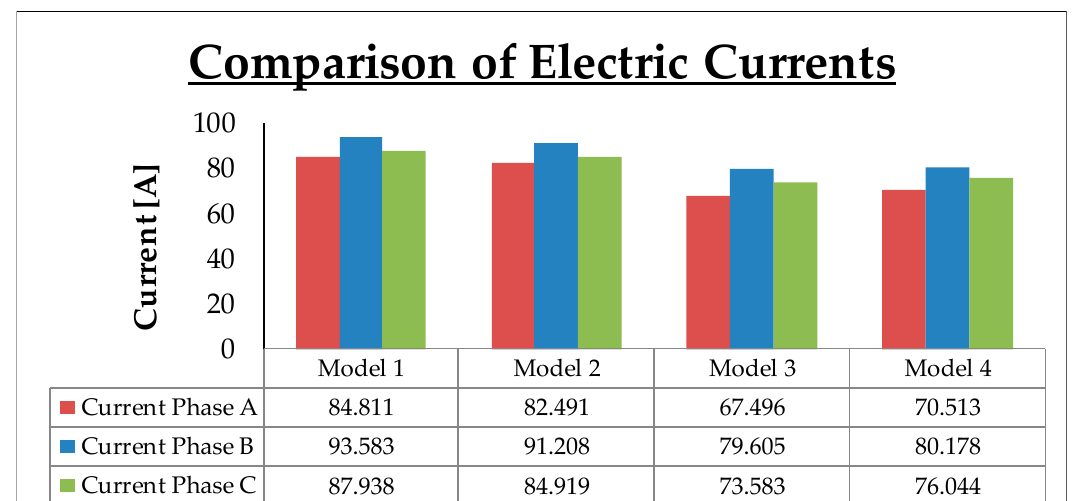
Figure 29. Electric currents per phase in each model.